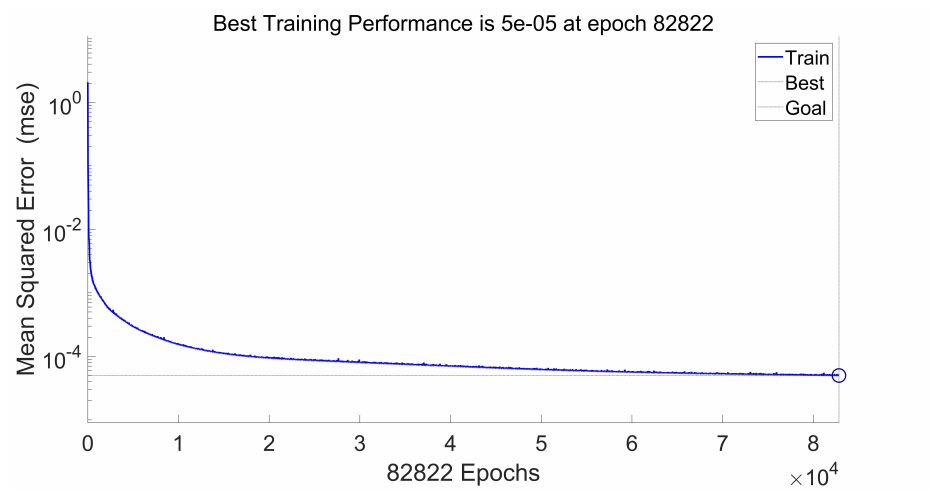
Figure 12. Elman neural network training process.